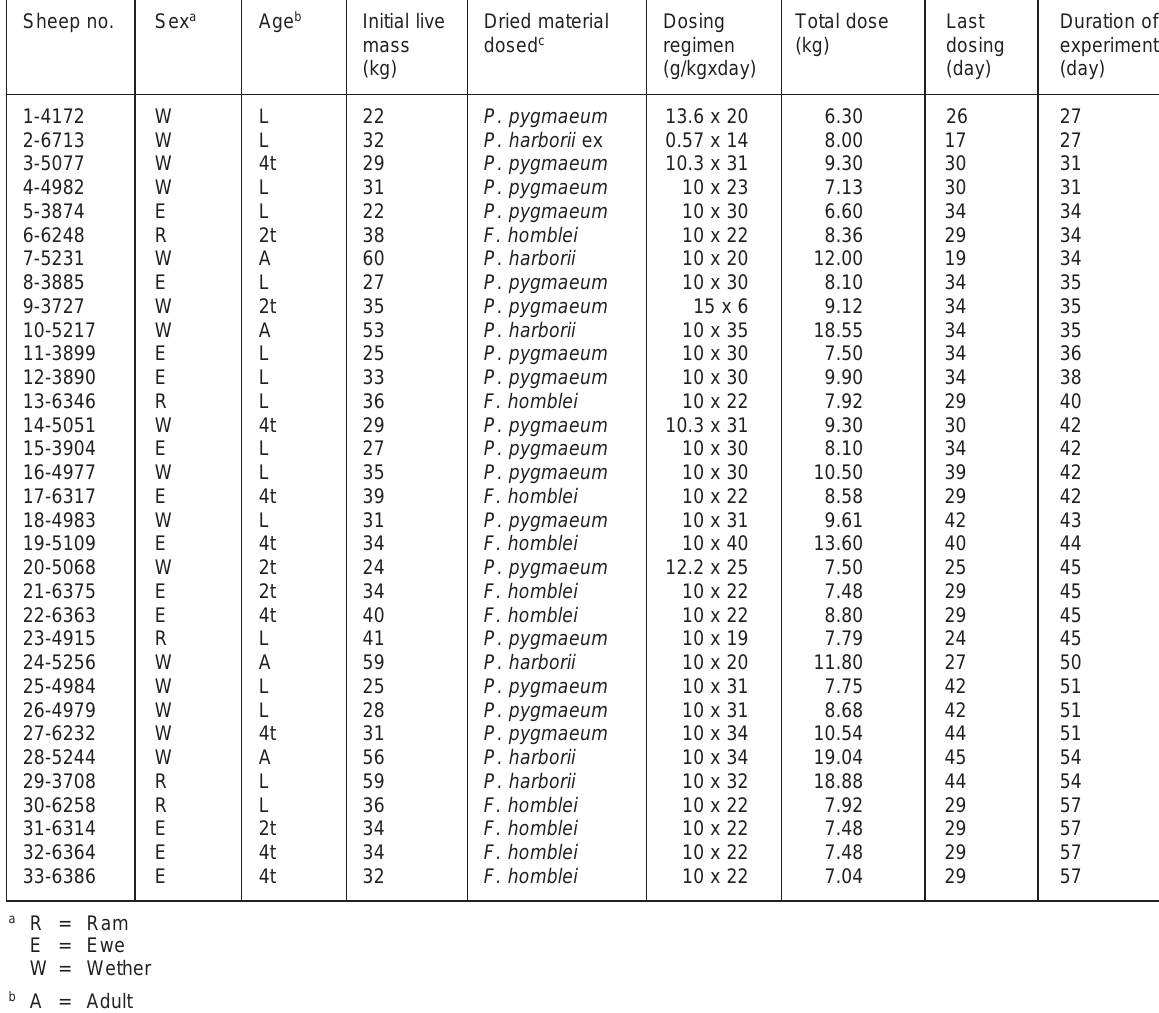
TABLE 1 Sheep examined in Series 1 after dosing with different gousiekte plants Sheep no.